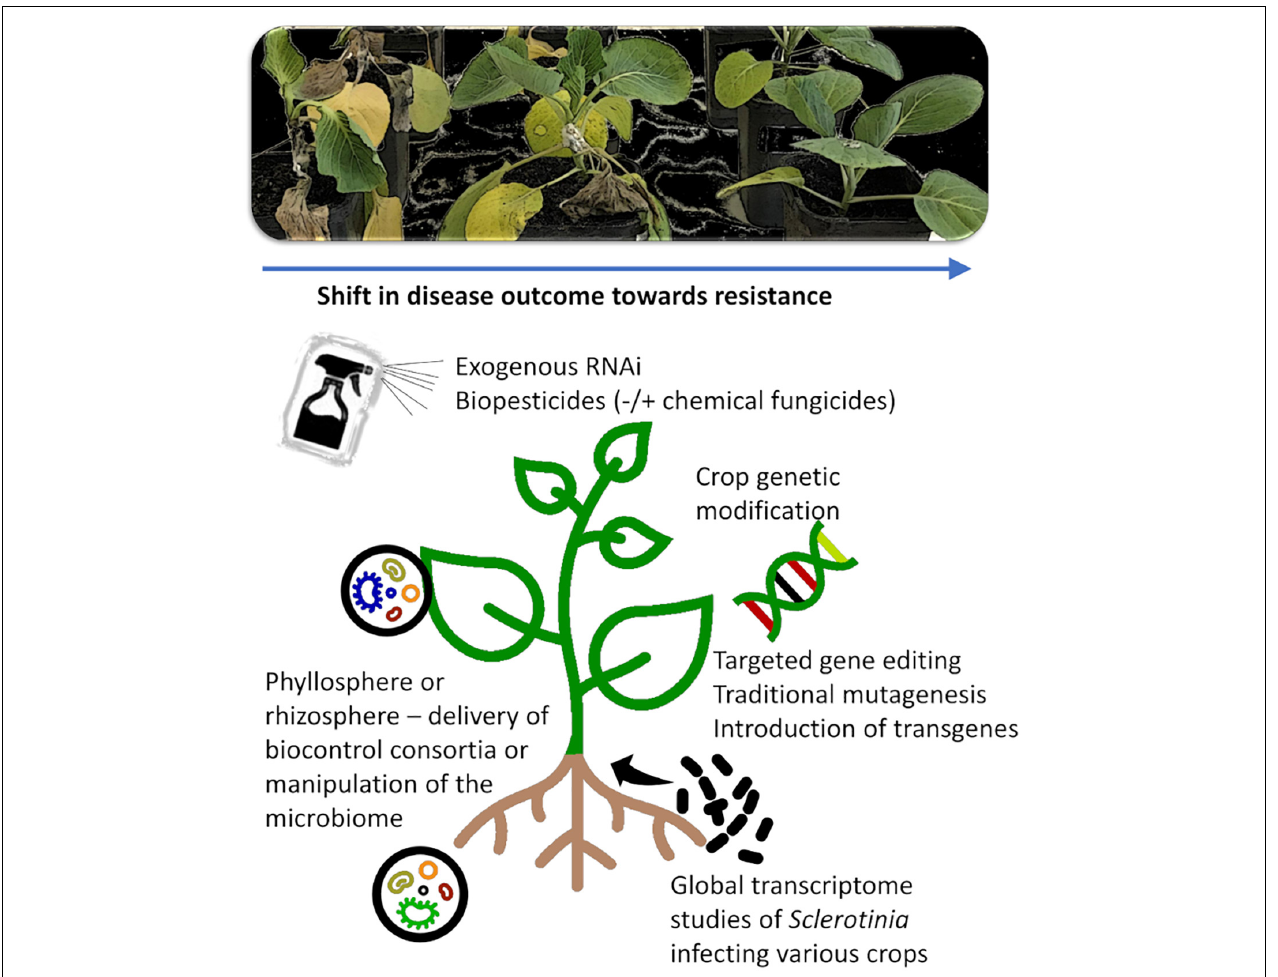
FIGURE 3 | New opportunities and tools for Sclerotinia control. New tools exist or are emerging that allow targeted manipulation of pathogen, host, or beneficial microbial populations that facilitate a reduction in Sclerotinia disease symptom development. These includes exogenous controls such as RNAi or biochemicals and biopesticides that can act directly on the pathogen (e.g., antifungal activity, fungal development) or indirectly by enhancing plant defense responses. Powerful endogenous controls such as crop genetic modification can provide durable resistance, but the process is costly, and not all crops are readily transformable or afford public acceptance. New knowledge of the pathogenicity and virulence of Sclerotinia species can be acquired through global omics studies on the pathogen infecting diverse crops of varying disease resistance, and this knowledge can be used to identify essential pathogen processes or weaknesses that can be targeted in new management